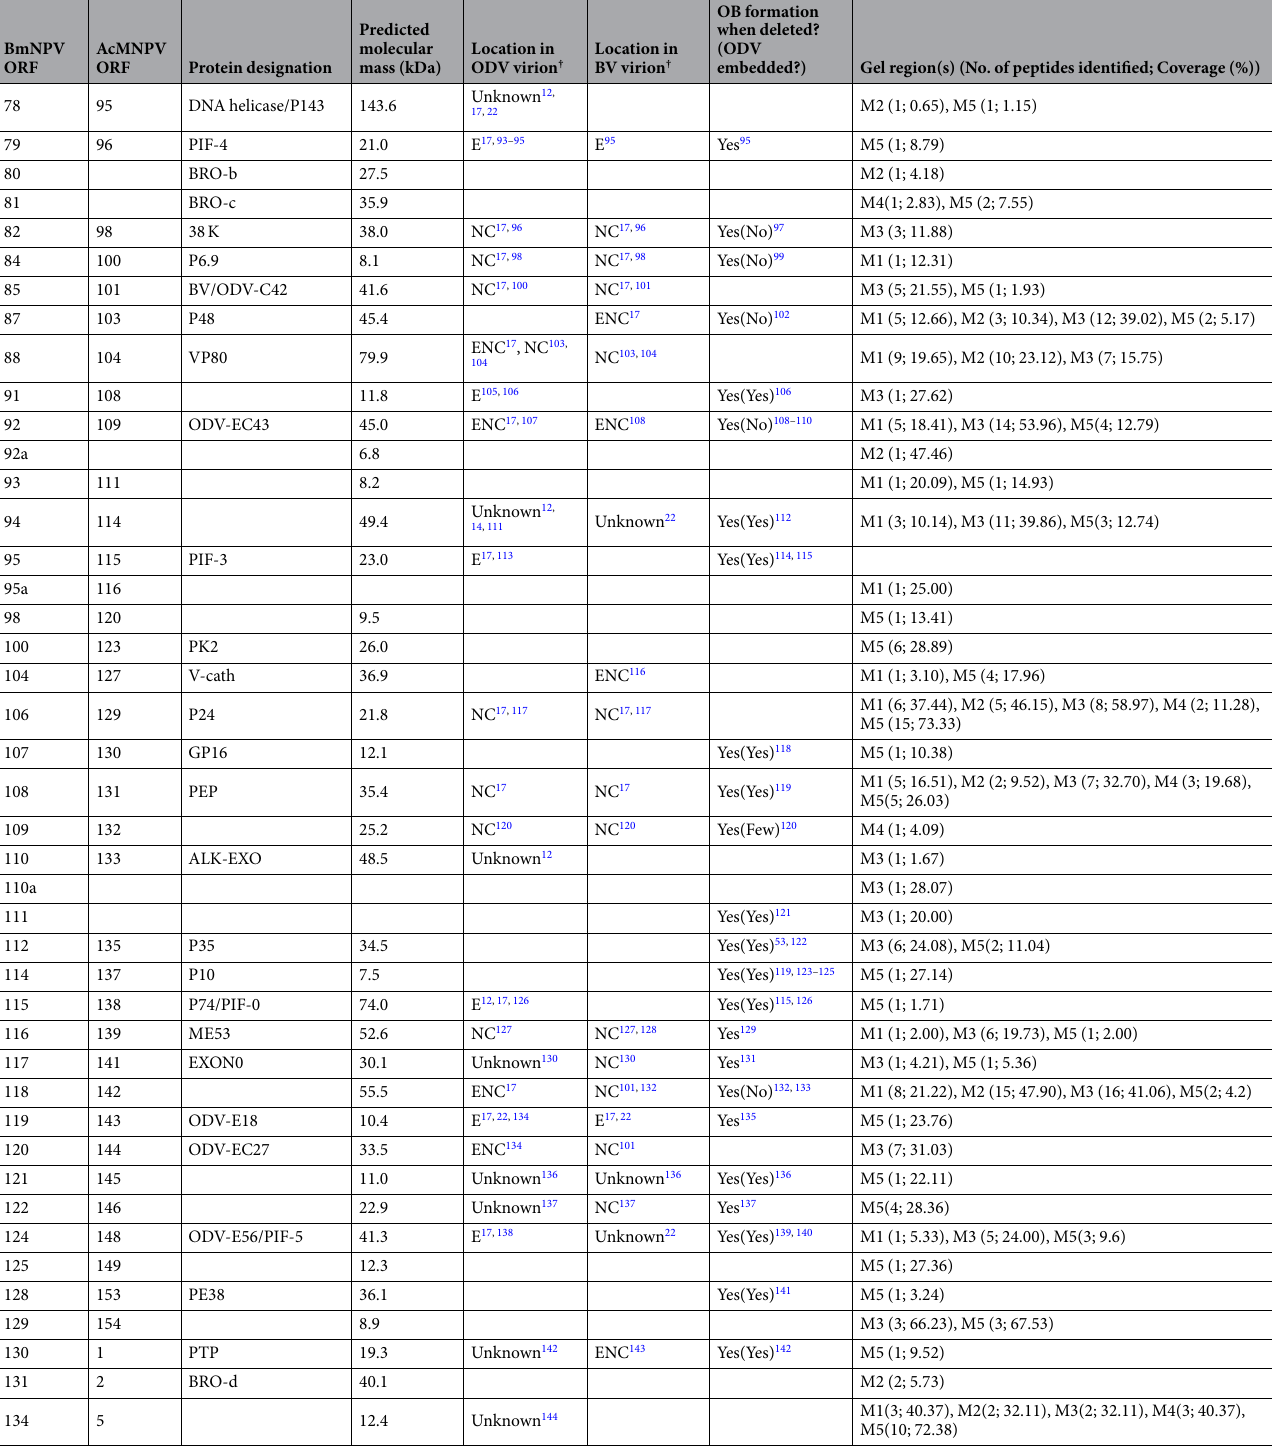
Table 2. Viral proteins identified in the BmNPV polyhedral matrix by a Q Exactive LC-ESI-MS/MS analysis. † Proteins were reported to be envelope (E)-, envelope-and-nucleocapsid (ENC)-, and/or nucleocapsid (NC)- associated components of BV and ODV in the